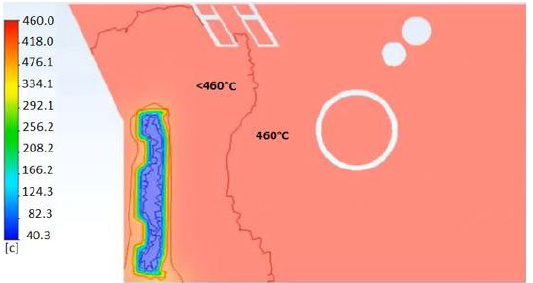
Figure 9. Temperature distribution with the solid ingot at 40° C 50% inserted into the zinc bath.